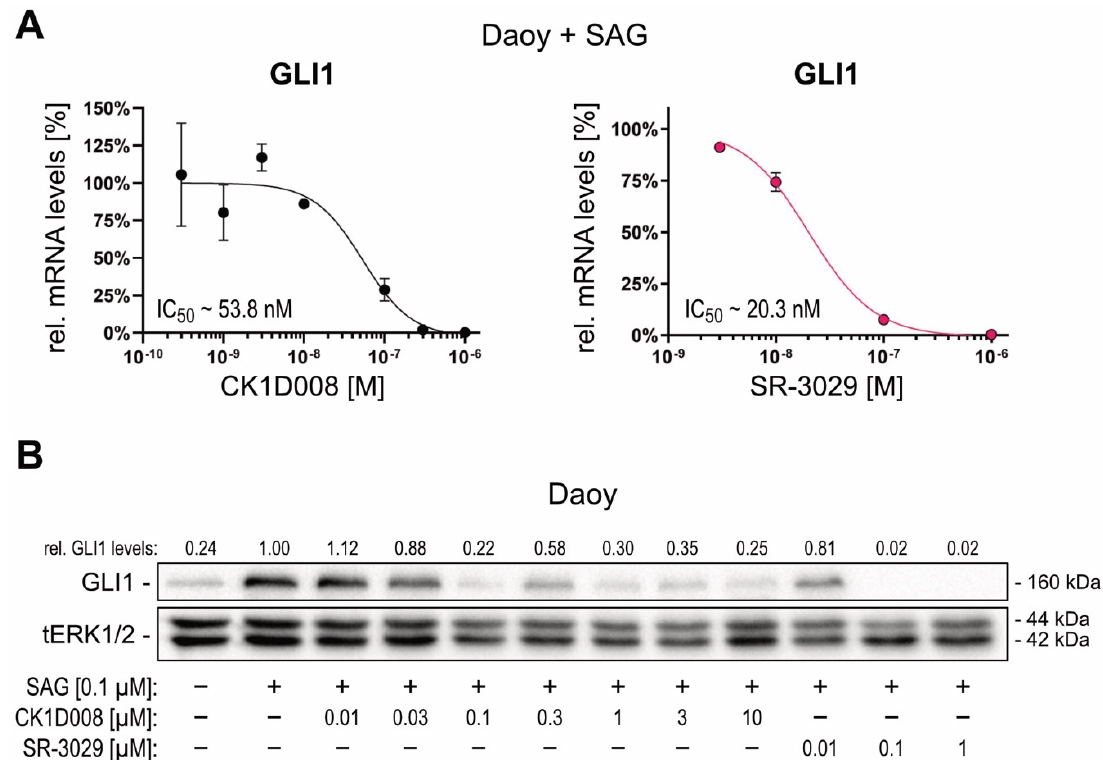
Figure 3. Pharmacological targeting of CSNK1D inhibits SMO-dependent GLI activation. ( A ) mRNA expression levels of GLI1 were analyzed by qPCR and expressed as percentage relative to the control sample ( n = 3). ( B ) Representative Western blot analysis of GLI1 protein levels in Daoy cells treated with SAG [100 nM] and increasing concentrations of CK1D008 [0.01–10 µM] or SR-3029 [0.01–1 µM]. Relative quantification of Western blot bands was conducted via densitometric image analysis using Image Lab 5.0 software (Bio-Rad, Vienna, Austria). Relative protein levels normalized to the loading control tERK and to the SAG-treated sample are shown above each protein band.